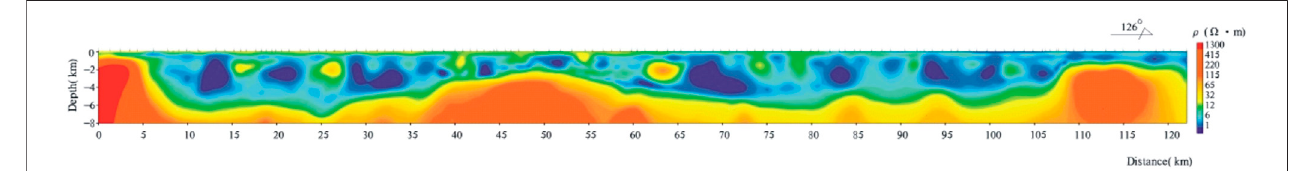
FIGURE 5 | 2D magnetotelluric inversion